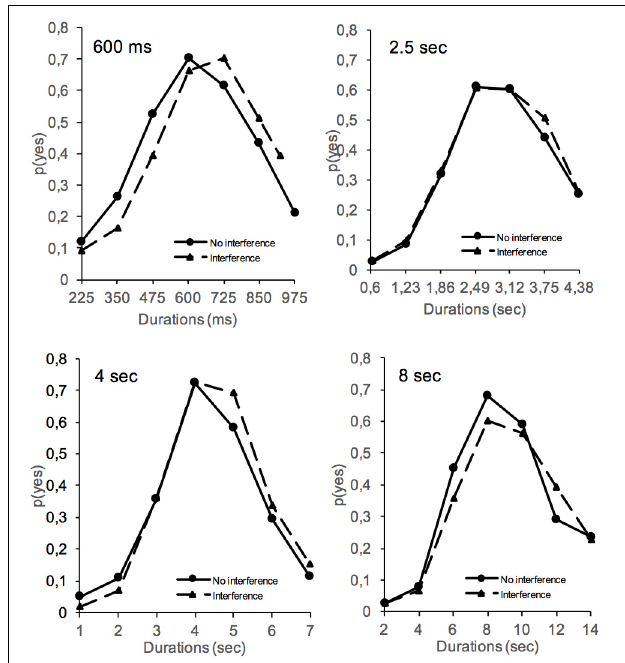
FIGURE 1 | Proportion of “yes” responses (meaning “it is the reference duration”) obtained in the long-term memory test (24 h after acquisition) plotted against stimulus durations for the 600-ms, 2.5-s, 4-s, and 8-s reference duration groups with (dashed lines) and without (solid lines) an interference task during the long-term memory consolidation process.